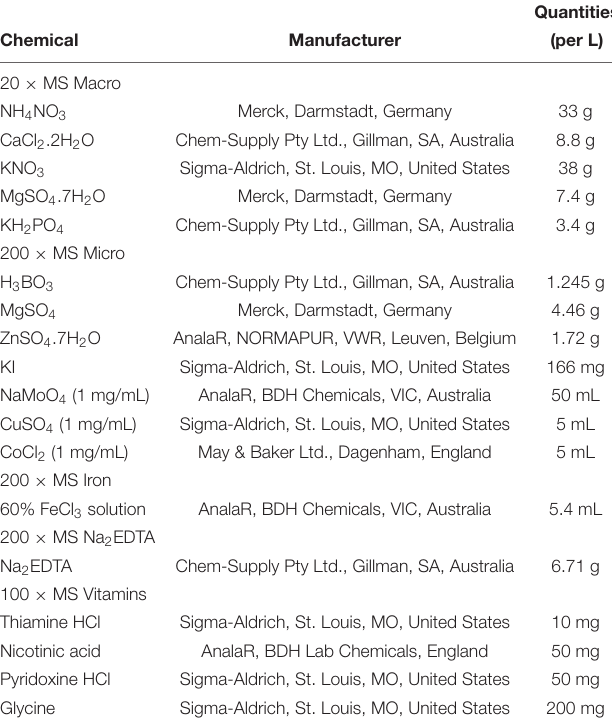
TABLE 2 | Components of Murashige and Skoog (1962) Macro stock